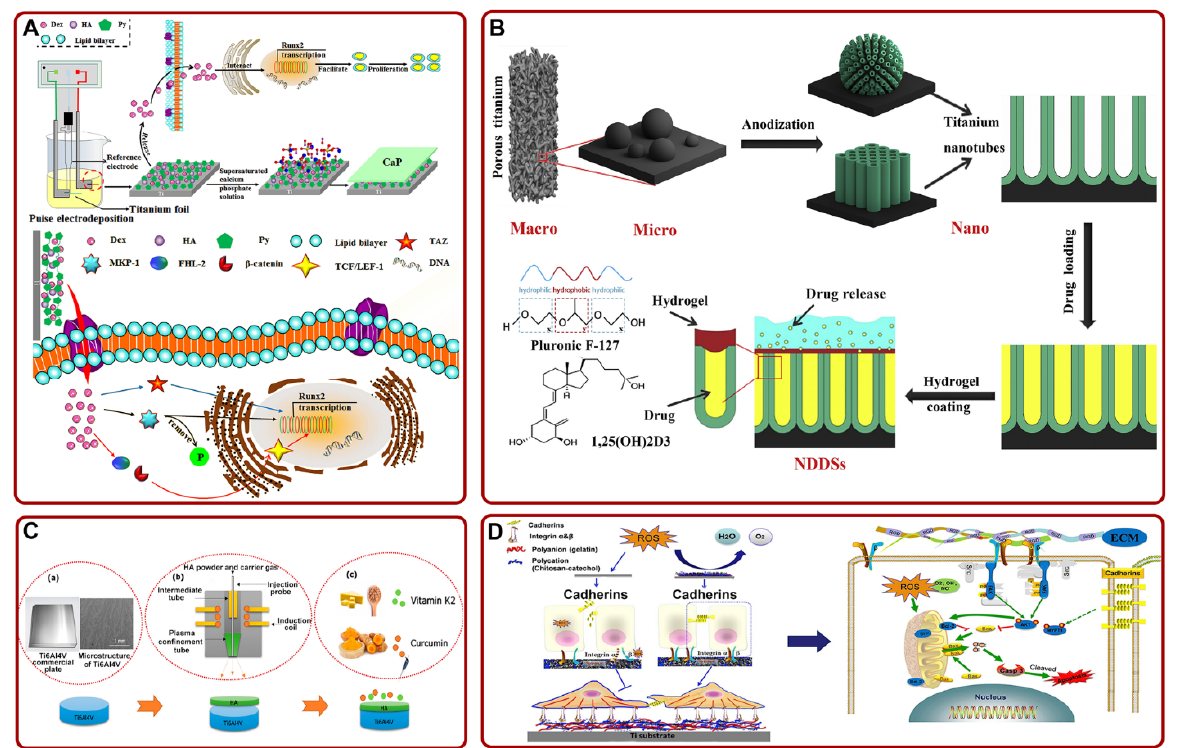
Figure 4. ( A ) Schematic of the mechanism that PPy@HA/Dex-composite-coated Ti promoted the osteogenic effect and osseointegration by activating Runx2. Adapted with permission from Ref. [150]. Copyright 2021, Elsevier; ( B ) a schematic diagram of constructing 1 α ,25-Dihydroxyvitamin D3-loaded hierarchical Ti scaffold. Adapted with permission from Ref. [152]. Copyright 2020, Elsevier; ( C ) the process of loading curcumin and vitamin K2 on HA-coated Ti6Al4V implant. Adapted with permission from Ref. [153]. Copyright 2020, American chemical society; ( D ) schematic of the proposed mechanisms of Chi-C/Gel/HA-composite-coated Ti in facilitating cell adhesion and inhibiting ROS damage. Adapted with permission from Ref. [154]. Copyright 2017, Elsevier. Abbreviations: Dex: dexamethasone; HA: hydroxyapatite; Py: pyrrole; TAZ: tafazzin; MKP-1: protein kinase phosphatase 1; FHL2: four-and-a-half LIM domains 2; TCF/LEF-1: the β -catenin binds to T-cell factor/lymphoid enhancer factor-1; NDDSs: nanoscale drug delivery systems; ROS: reactive oxygen species.